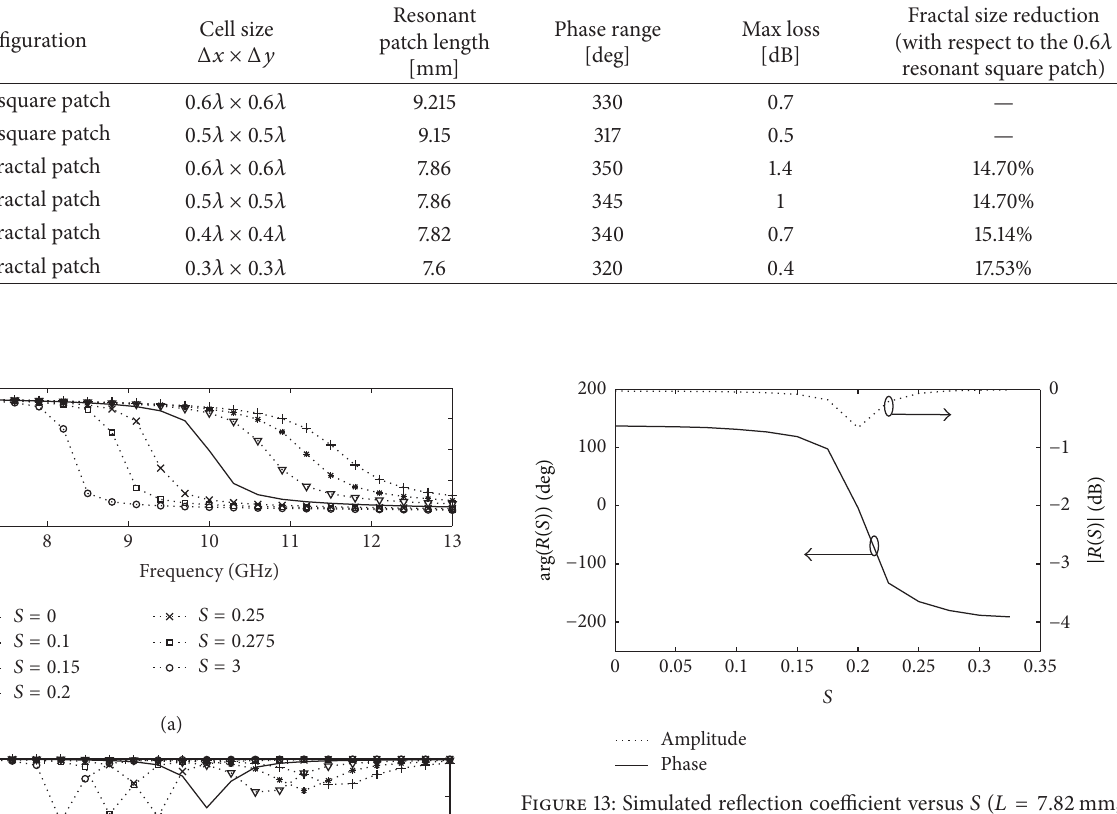
× 0.4𝜆 𝑓 = 10 0 0 , and 0